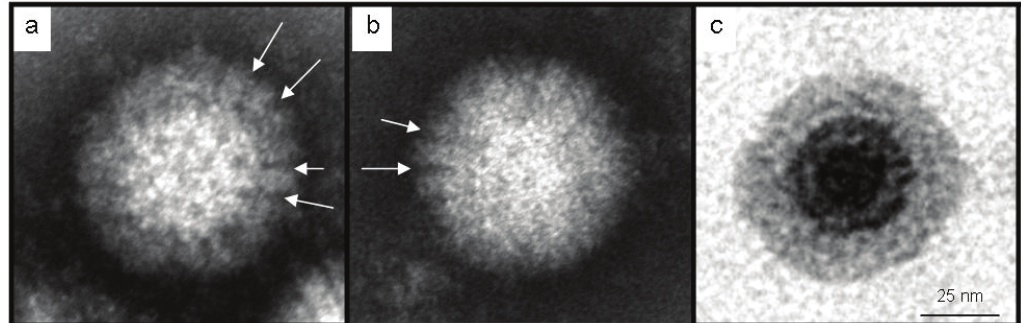
Figure 5. Virion ultrastructure of MAHLV isolate 06-24. ( a ) Negatively-stained particle with two distinct layers; ( b ) icosahedral negatively-stained particle; ( c ) resin-embedded, sectioned viral particle in cytoplasm of infected Vero E6 cell. White arrows indicate some of the characteristic spaces between the finger-like, capsomeric projections surrounding the solvent channels through the outer capsid layer.